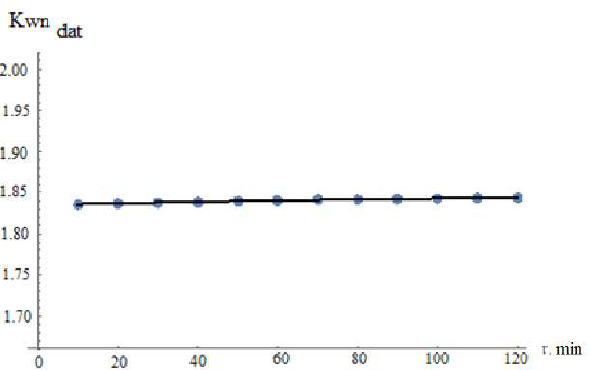
Figure 3. Dependence of the polydispersity coefficient of the Kwn dat fraction of diblock polypropy- lene chains starting their growth on the 2nd type of AC on the residence time in the reactor (calculated with the basic values of the model parameters). The effect of changing the donor concentration is shown in Figures